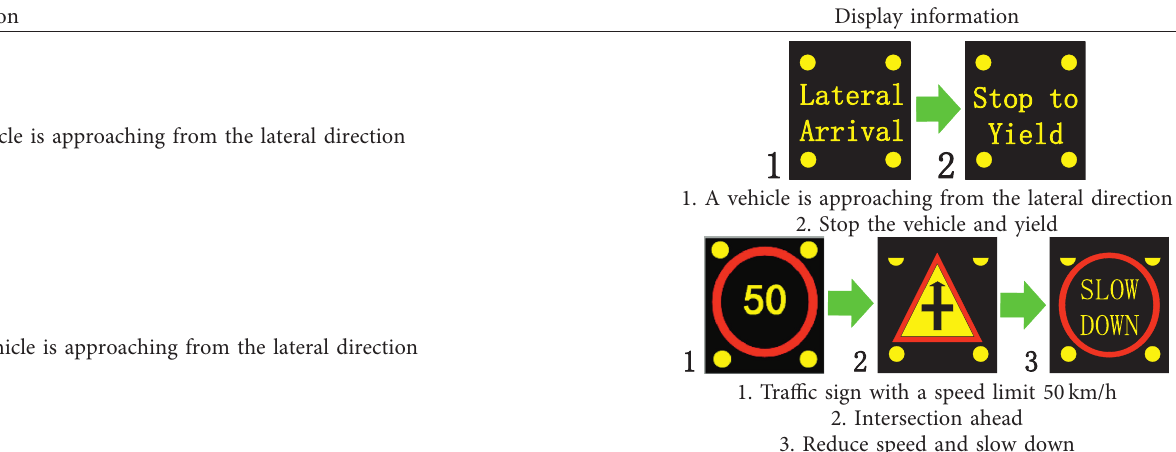
Table 1: Warning strategy of